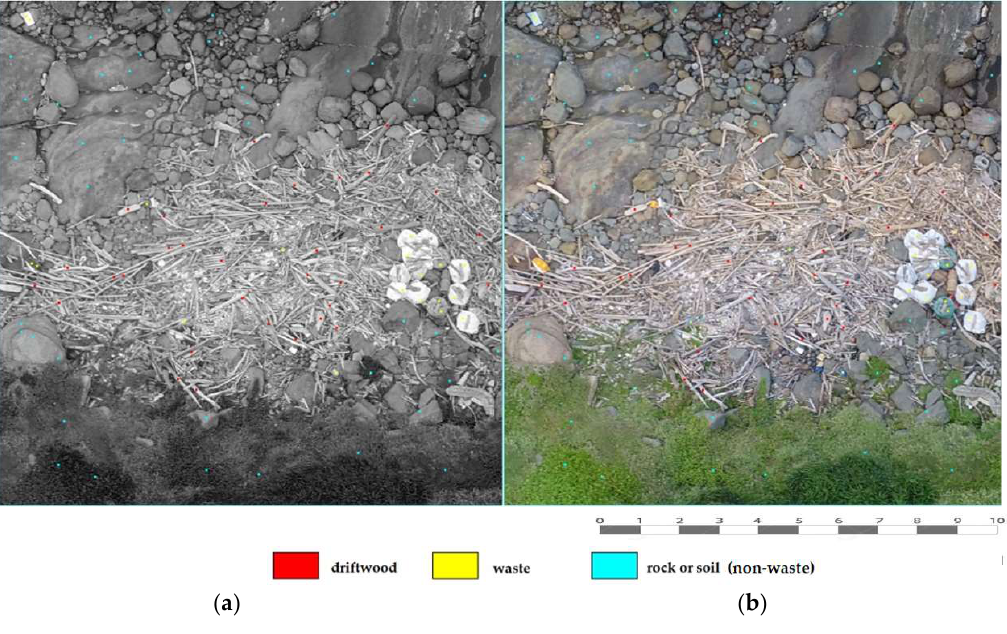
Figure 3. Sampling by ( a ) GLCM ( b ) color image. Table 1. Formula list of vegetation indices and texture